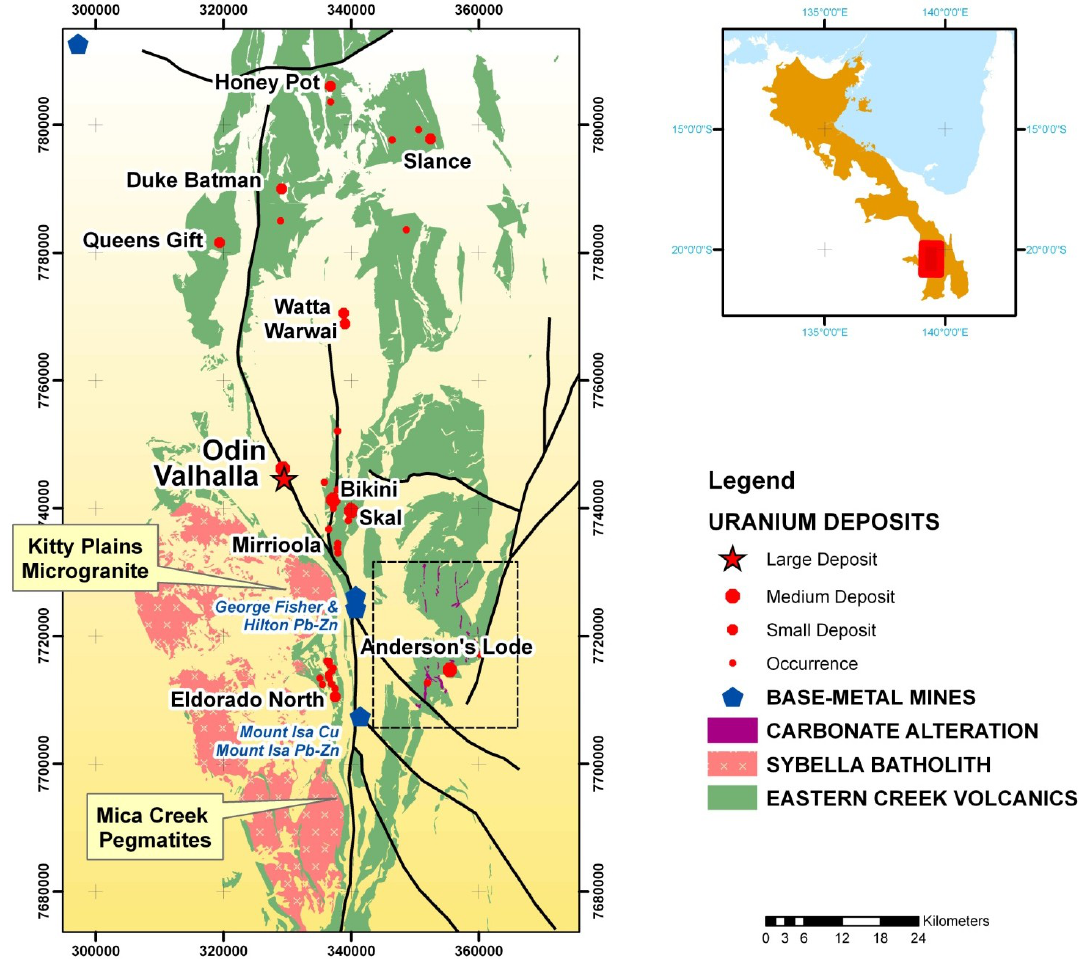
Figure 1. Simplified geology of part of the Mount Isa uranium district. The location map shows the extent of the North Australian Proterozoic province in orange. The dashed rectangle shows the extent of 1:35,000 scale mapping of regional carbonate-iron oxide alteration